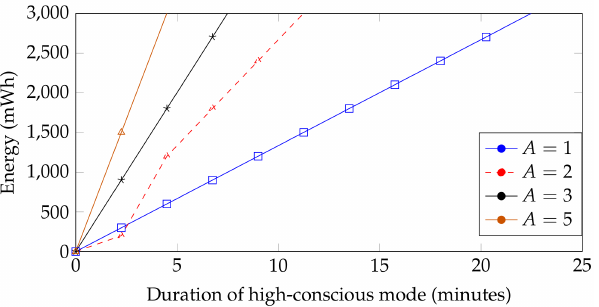
Figure 9. Energy consumption of the swarm based on the average duration that the agents stay at high-conscious